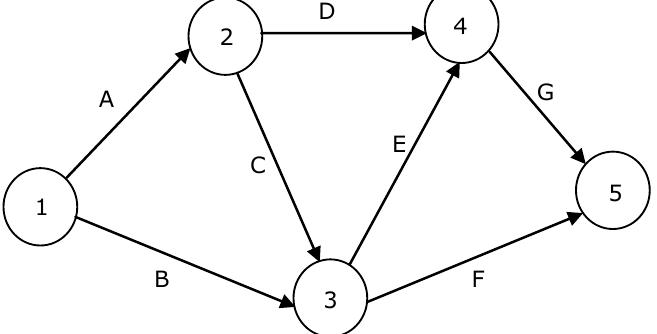
Figure 6. CPM network of the project on new product (Pre-paid electric meter, a project